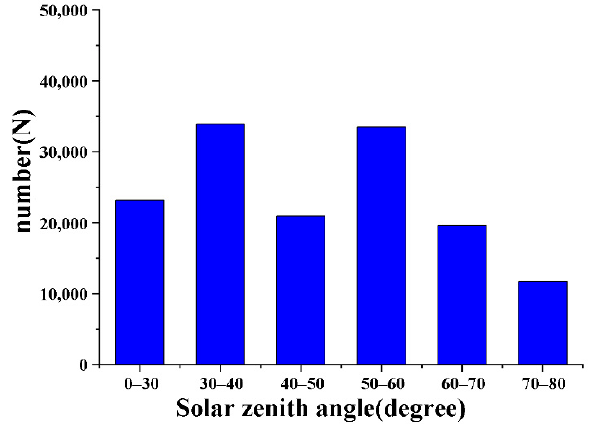
Figure 2. The distribution of the SZA in the neural network training Figure 2 . The distribution of the SZA in the neural network training dataset .